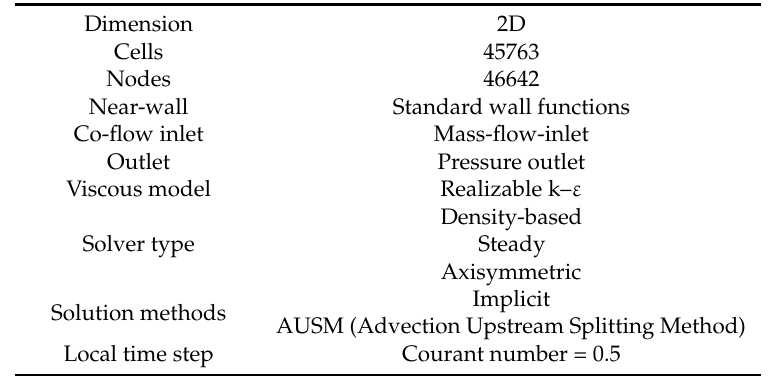
Table 3. Parameters and settings of the computational fluid dynamics (CFD) model.